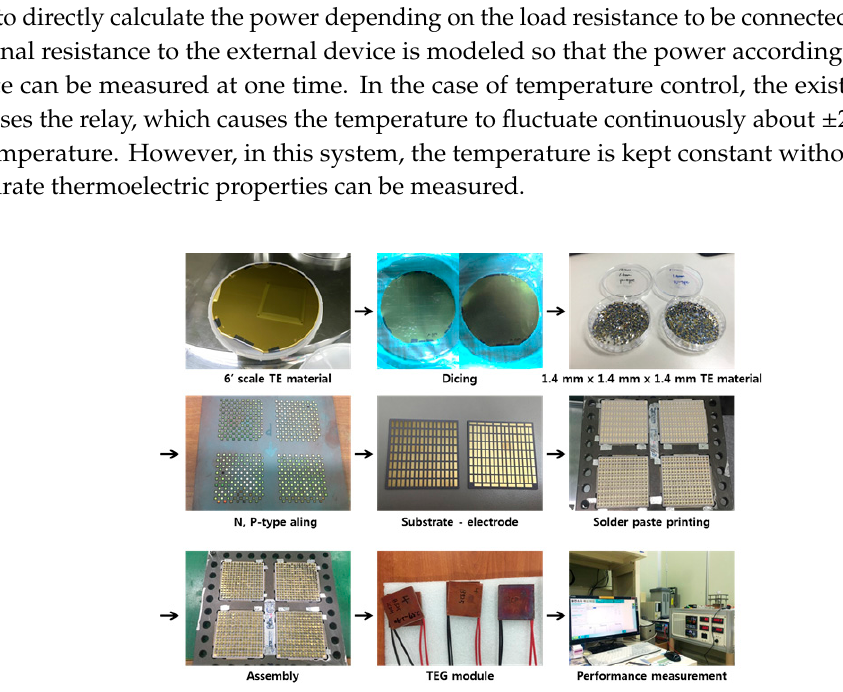
Figure 6. The fabrication process Si thermoelectric module with Si substrate for mass production process.